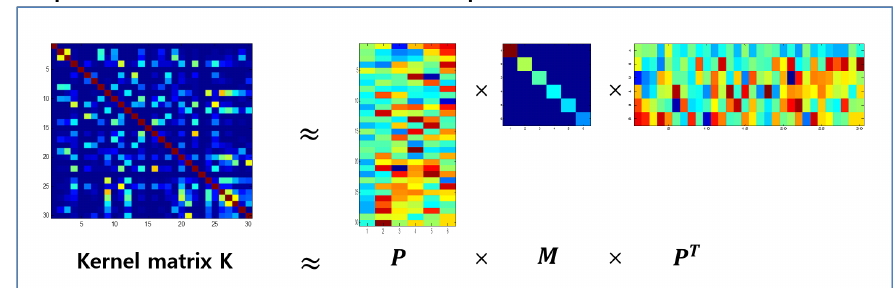
Figure 2. Graphical representation of the kernel matrix factorization [24] (reproduced with permission from Eunwoo Kim, Sungjoon Choi, Songhwai Oh, Structured Low-Rank Matrix Approximation in Gaussian Process Regression for Autonomous Robot Navigation; published by IEEE, 2015), where a kernel matrix K is decomposed into three factors. Based on the decomposition, we can learn AR-GP with the low-rank kernel